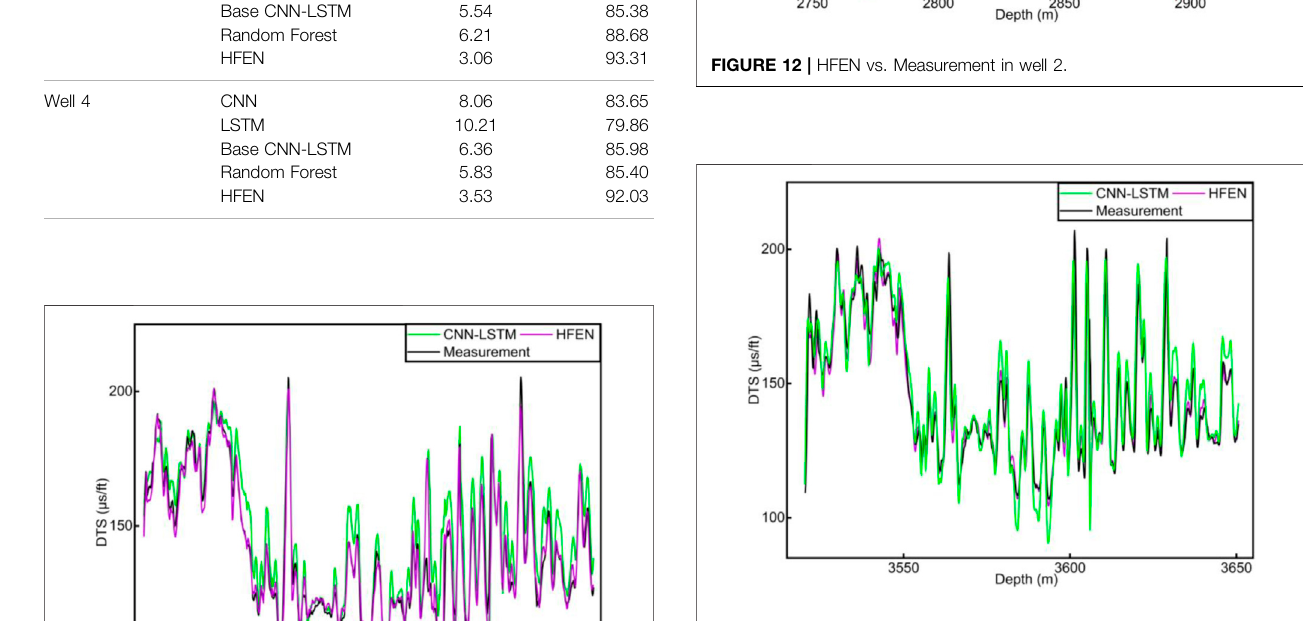
FIGURE 13 | HFEN vs. Measurement in well 3.